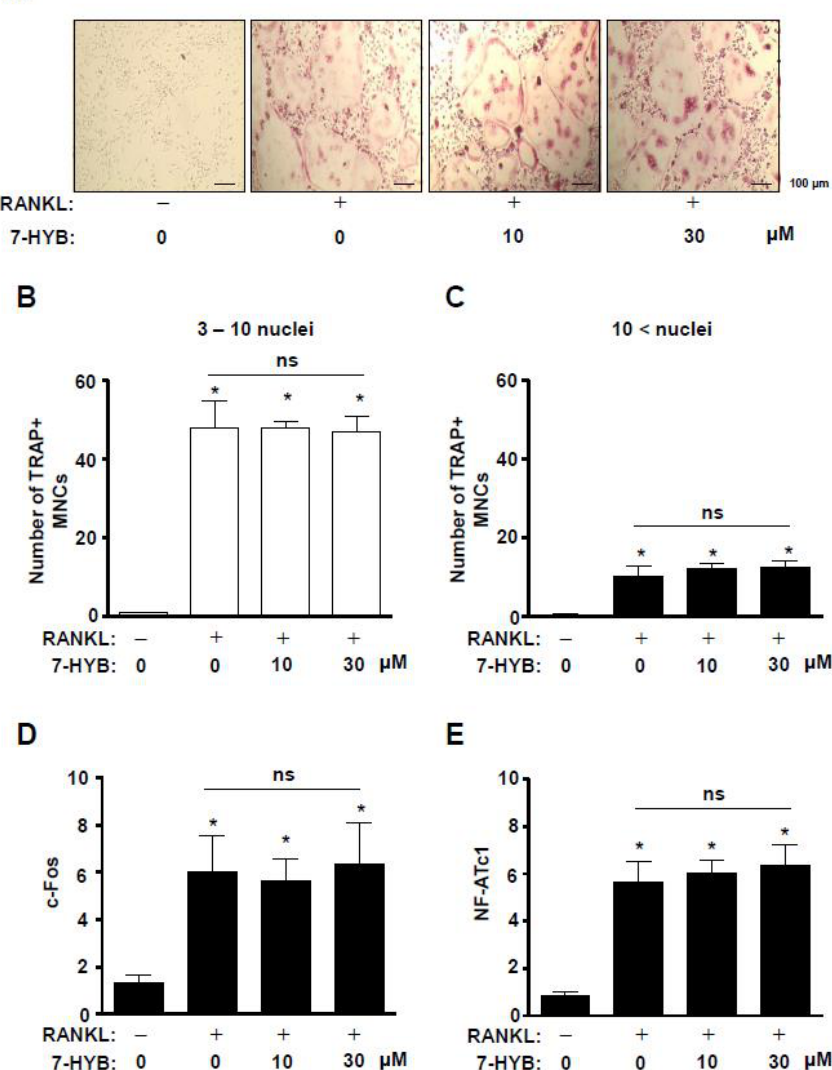
Figure 7. E ff ect of 7-HYB on TRAP-positive multinucleated osteoclasts (MNCs) and gene expression in RANKL-induced osteoclastogenesis. ( A – C ) BMMs were cultured in M-CSF (30 ng / mL) and RANKL (100 ng / mL) with 7-HYB (10 and 30 µ M) for five days. TRAP staining were observed using a light microscope ( A ), and the numbers of TRAP-positive MNCs with 3–10 nuclei ( B ) and > 10 nuclei ( C ) were counted. Scale bar: 200 µ m. ( D , E ) After BMMs were cultured in M-CSF (30 ng / mL) and RANKL (100 ng / mL) with 7-HYB (10 and 30 µ M) for three days, c-Fos ( D ) and NF-ATc1 ( E ) were analyzed by qRT-PCR and the values obtained for the target gene expression were expressed as a bar graph. Data represent the mean ± S.E.M. of experiments. *, p < 0.05: statistically significant di ff erence when compared to the control. ns: no significant di ff erence when compared to